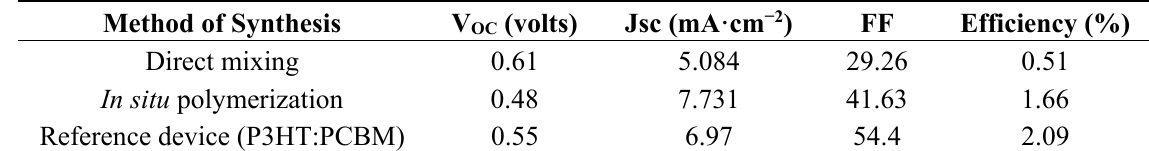
Table 2. Measured cell